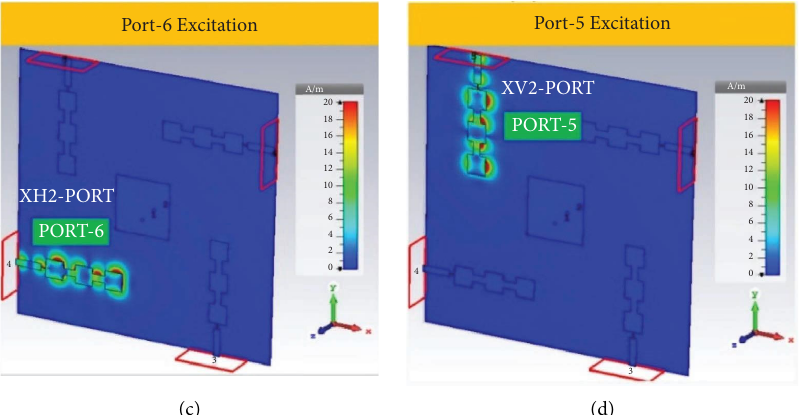
Figure 9: (a) Surface current distribution of XV1-port (port-3). (b) Surface current distribution of XH1-port (port-4). (c) Surface current distribution of XH2-port (port-6). (d) Surface current distribution of XV2-Port (port-5).